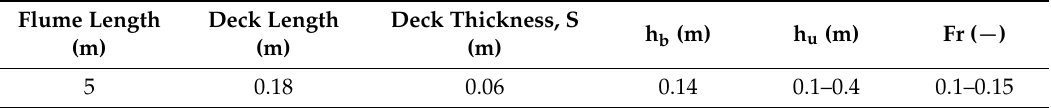
Table 4. Summary of the experimental conditions used for Fluent model validation.